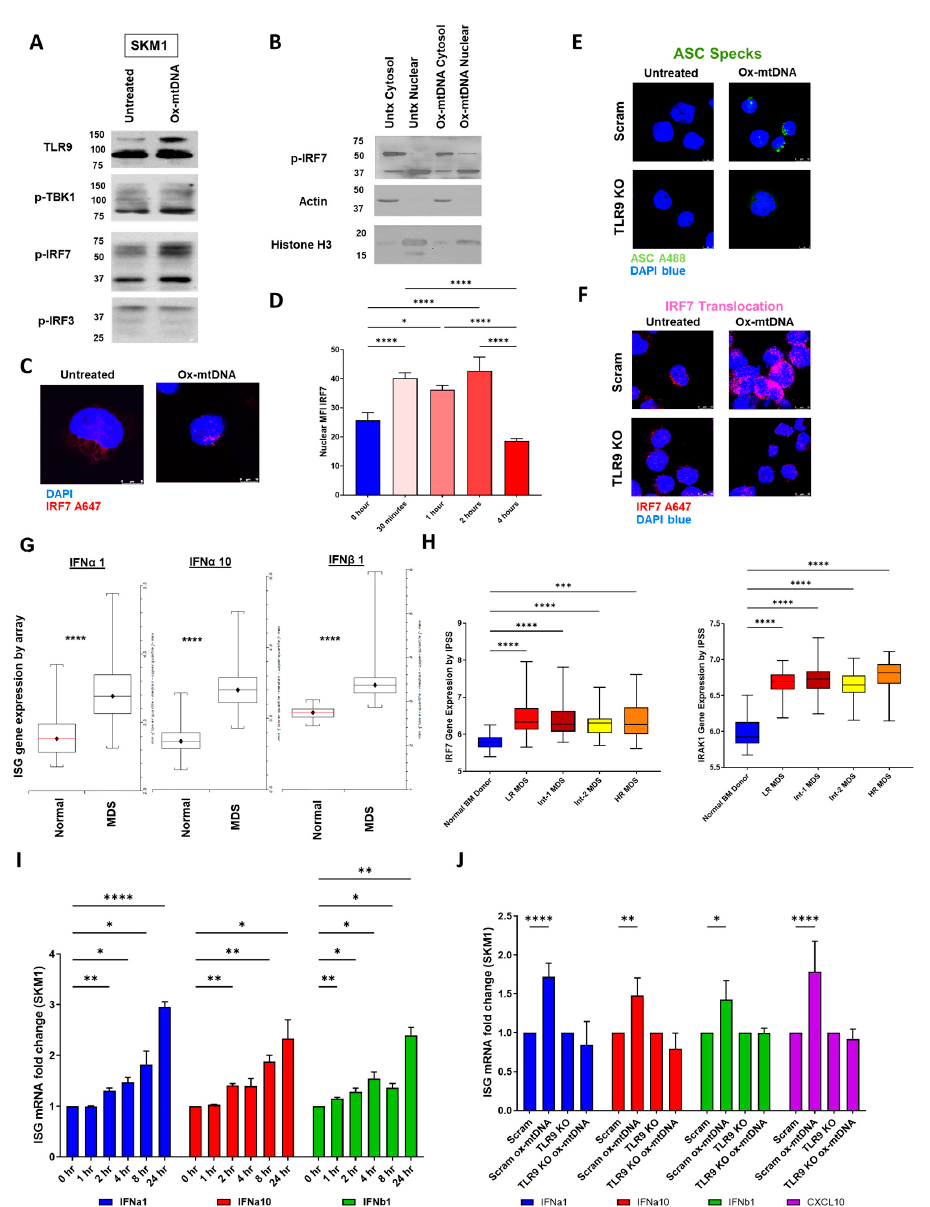
Figure 4. IRF7 signaling is activated by ox-mtDNA/TLR9 engagement. ( A ) TLR9 pathway activation demonstrated by TLR9 cleavage, and IRF7 phosphorylation. TBK1 and IRF3 unchanged suggesting other DNA sensing pathways are not activated. Representative Western Blot. ( B ) IRF7 translocation to the nucleus (cytosol denoted by presence of actin, nucleus denoted by presence of Histone H3. Representative Fractionation Western Blot. ( C ) Confocal IF to demonstrate IRF7 translocation, [DAPI (blue), IRF7 (Alexa Fluro 647) (×2520)]. ( D ) Quantification of nuclear MFI of IRF7 (translocation) of IF of SKM1 cells treated with ox-mtDNA at the times shown. Significance was assessed by ordinary one-way ANOVA. ( E ) Confocal IF of TLR9 KO on ASC speck formation and ( F ) IRF7 nuclear translocation [DAPI (blue), ASC (Alexa Fluro 488), IRF7 (Alexa Fluro 647) (×2520)]. ( G ) Gene expression array of Type 1 interferons IFN α 1, α 10, β 1 (shown) although IFN α 1, 2, 4, 5, 8, 10, 14, and 21 were all significantly elevated (MDS n = 213, BMT donors n = 20). ( H ) IRF7 and Interleukin 1 Receptor Associated Kinase (IRAK)1 (n = 213, BMT donors n = 20). ( I ) Quantitative qPCR of IFNa1, IFNa10, IFNb1 gene expression in SKM1 cells treated with 50 ng/mL ox-mtDNA treatment 1–24 h (mean fold change ± SEM, n = 3). ( J ) Quantitative qPCR of IFNa1, IFNa10, IFNb1 and CXCL10 gene expression in SKM1 cells, with or without TLR9 CRISPR KO, treated with 50 ng/mL ox-mtDNA (mean fold change ± SEM, n = 3). p values are shown as asterisk: * p ≤ 0.05, ** p ≤ 0.01, *** p ≤ 0.001, **** p ≤